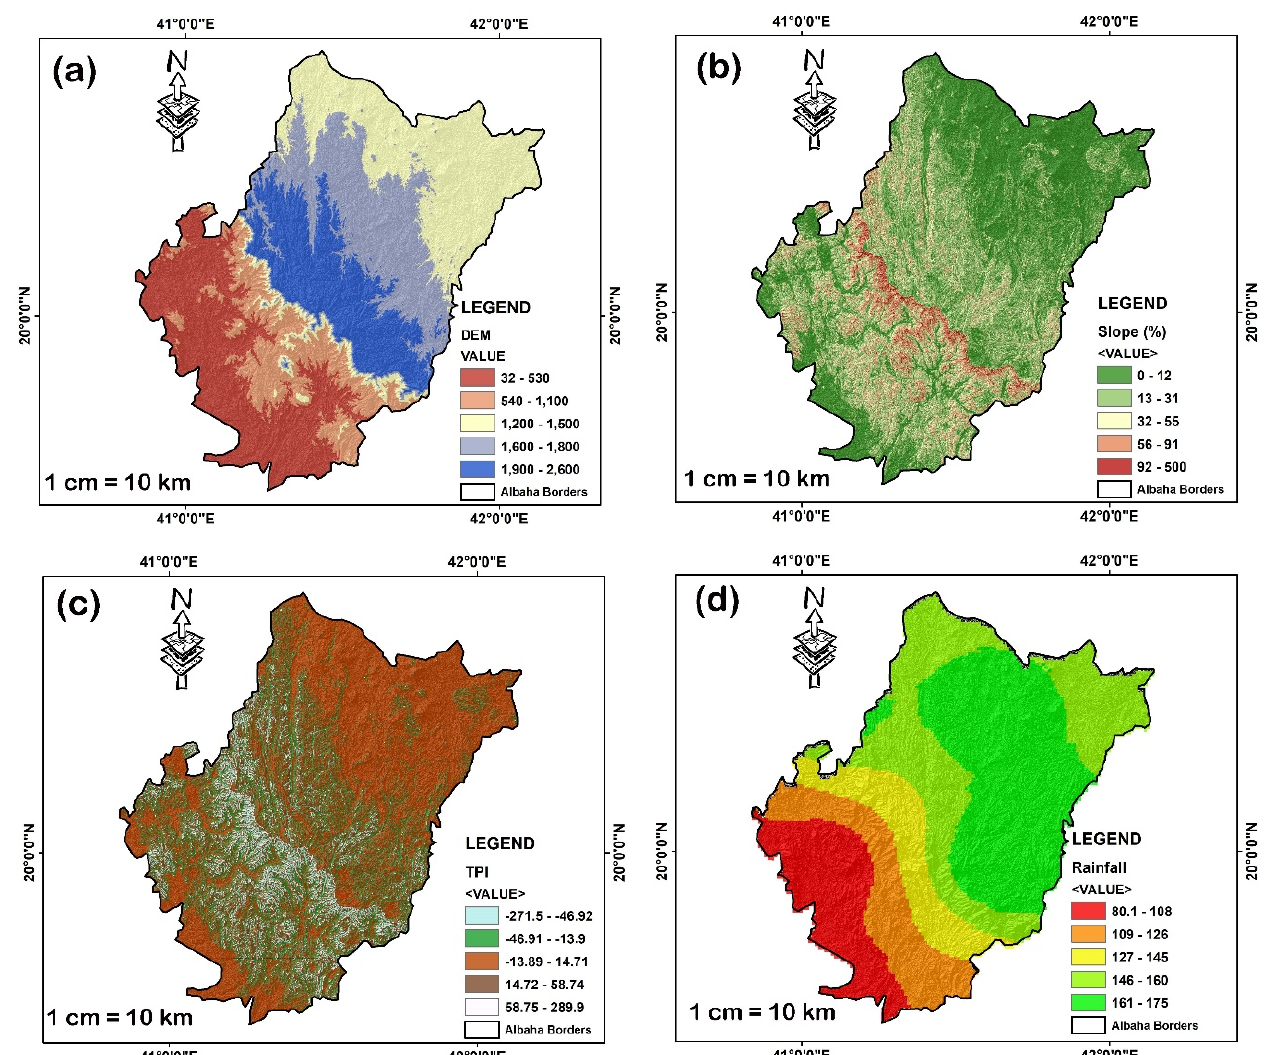
Figure 2. Representation of ( a ) DEM, ( b ) slope, ( c ) topographic position index, ( d ) rainfall.